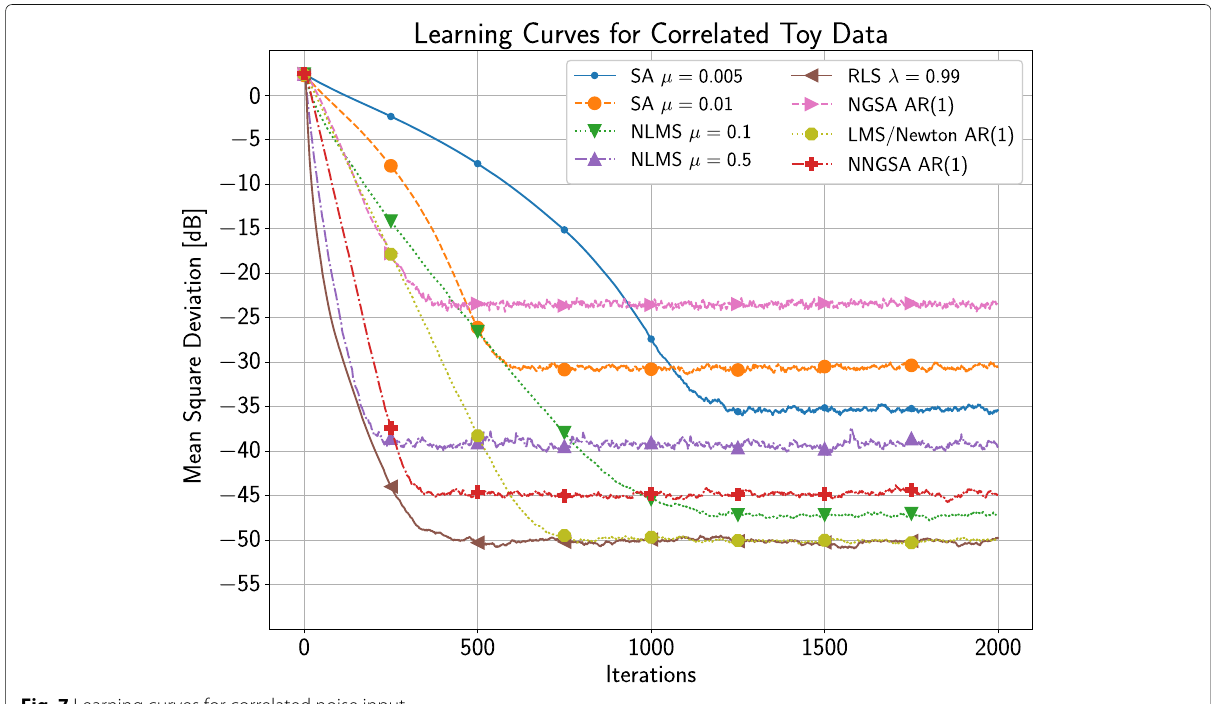
Fig. 7 Learning curves for correlated noise input